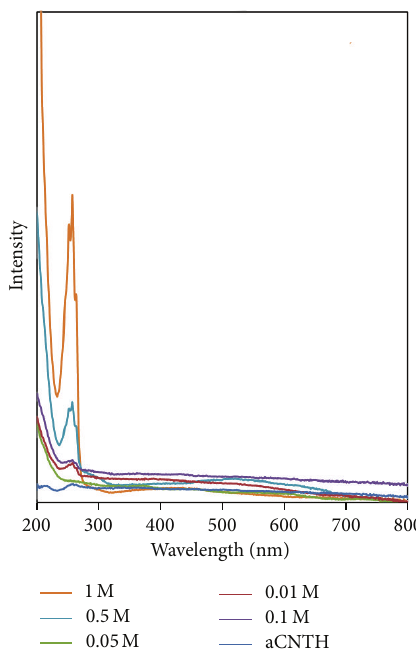
Figure 10: Absorption spectra of HNO 3 functionalized 𝛼 CNTN/Ag nanohybrids at different molars of AgNO 3